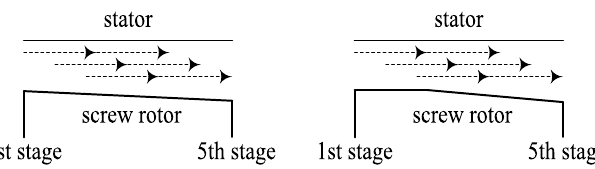
Fig. 16. Two variable distance gradient design for circumfer- ential